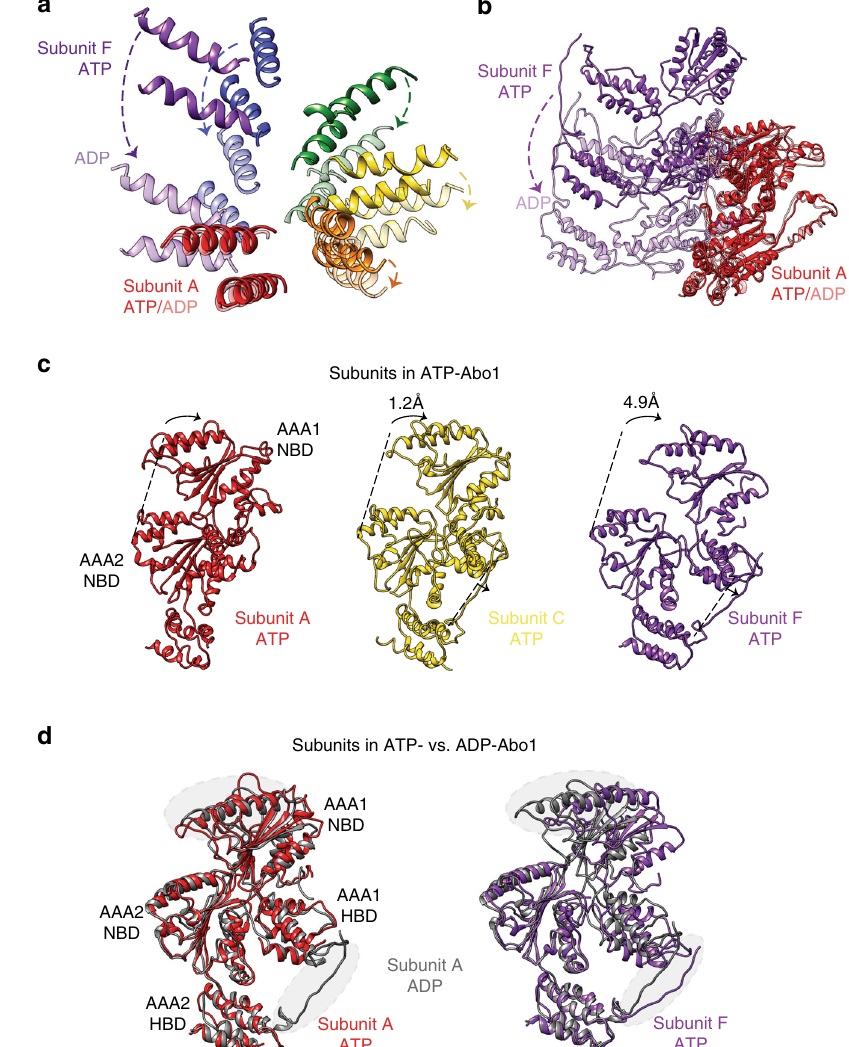
Fig. 5 The hexameric spiral-to-ring transition of Abo1 is mediated by subunit and AAA1/2 domain movements. a Rearrangement of Abo1 hexamer subunits from a spiral staircase (ATP state, bold colors) to a planar ring (ADP state, faded colors), as represented by the change in positions of AAA1 NBD α 2 and α 3. The two structures are superimposed by alignment at subunit A, and arrows depict the degree of movement of each subunit from the ATP to ADP state. b ATP (bold colors)-to-ADP (faded colors) structural transition of Abo1 subunit A and F. Structures are aligned by the AAA2 domain of subunit A. c Comparison of individual subunits of ATP-Abo1 (subunits A, C, and F) juxtaposed in the same con fi guration when aligned by AAA2. AAA1 NBD and the linker arm move away from AAA2 NBD. AAA1 NBD and AAA2 NBD centroid positions are further apart in subunits C and F by 1.2 and 4.9 Å, respectively, when compared to subunit A. The angle the two NBDs form with respect to AAA2 HBD is also shifted by 1 and 11 degrees in subunits C and F when compared to subunit A. d Superimposition of the ADP-Abo1 subunit A (which is representative of all other ADP-Abo1 subunits) onto ATP-Abo1 subunit A and F. ATP-subunit A superimposes well onto ADP-subunit, but ATP-subunit F shows a signi fi cant divergence most prominently seen in AAA1 NBD and the linker